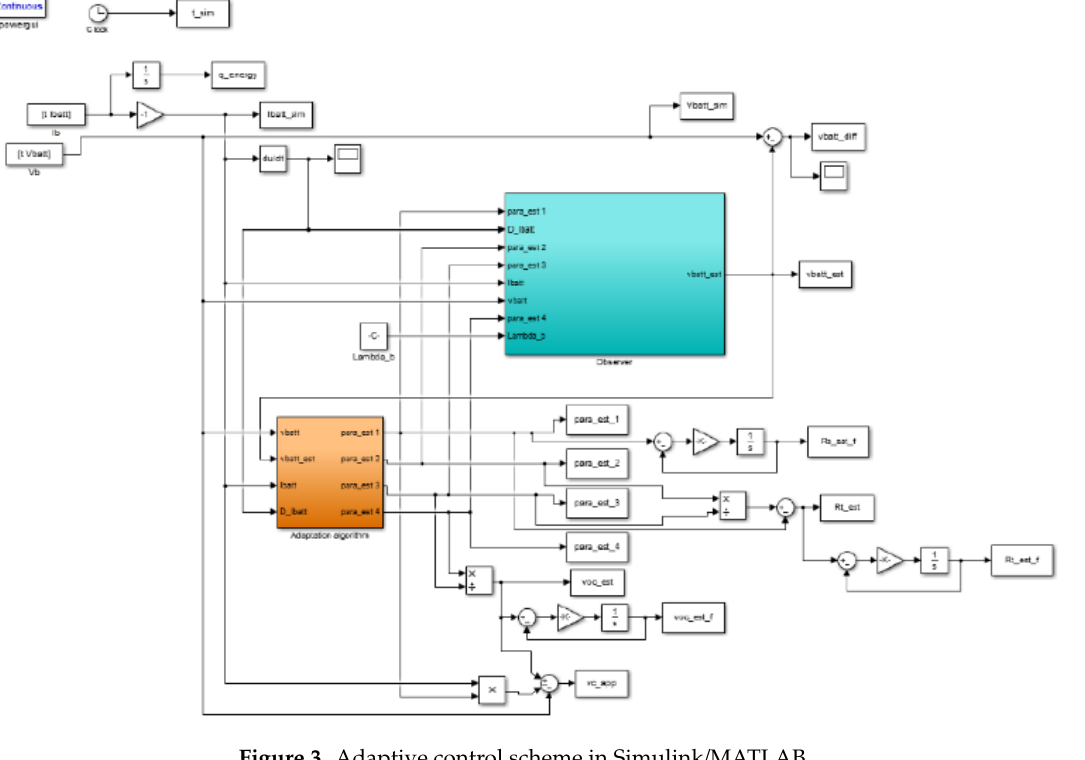
Figure 3. Adaptive control scheme in Simulink/MATLAB.